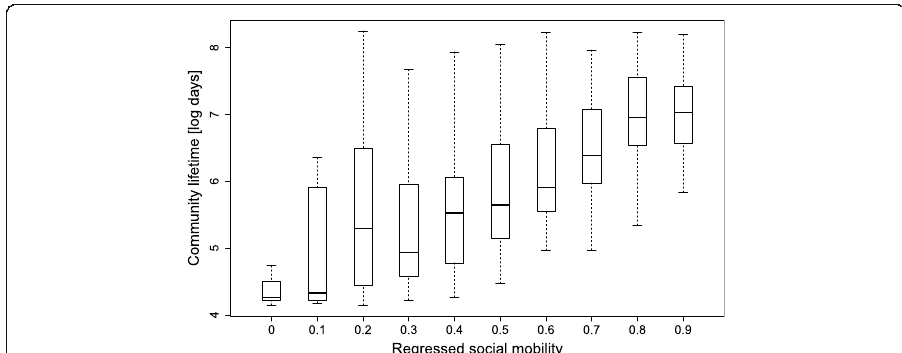
Fig. 8 A box plot of the distribution of the natural log of community lifetimes in days, as a function of regressed social mobility. The solid horizontal line in each box represents the median and the box represents the 2nd and 3rd quartiles. The dotted lines designate the 1st and 4th quartiles of the lifetime distribution. Only communities with more than 200 posts were used in the analysis